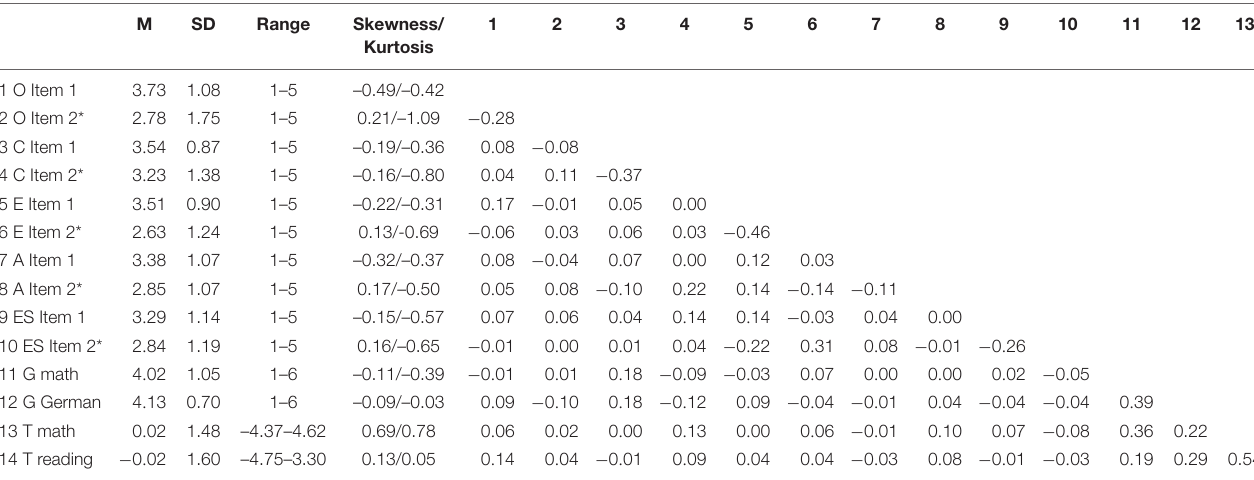
TABLE 1 | Descriptive statistics for BFI-10 items, teacher-assigned grades and standardized test